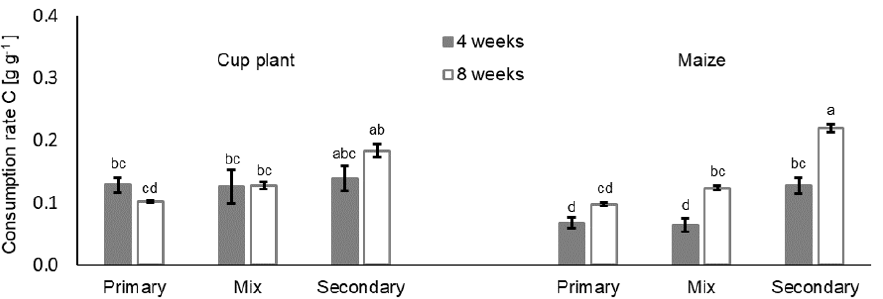
Figure 2. Consumption rate C [g g − 1 ] (means ± SE, n = 5) of primary decomposers L. terrestris (primary), secondary decomposers A. caliginosa and A. rosea (secondary) and a mix of both decomposer guilds (mix) in cup plant and maize treatments after 4 and 8 weeks of incubation. For statistics see Table 3 and Supplementary Information Table S6; for further information see Supplementary Infor- mation, Tables S1 and S2.